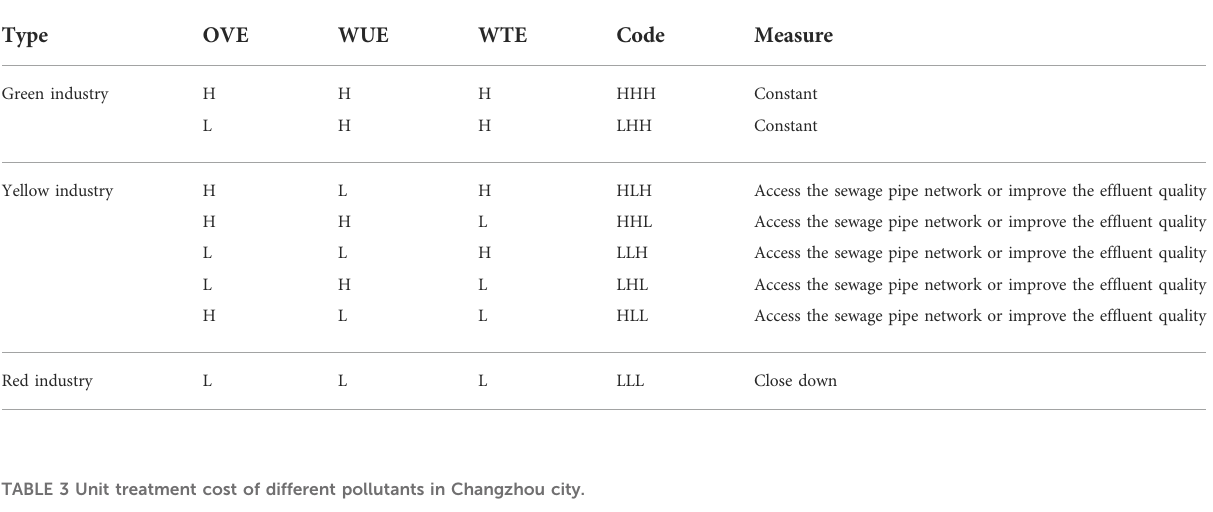
TABLE 2 Industrial type and regulatory measures.